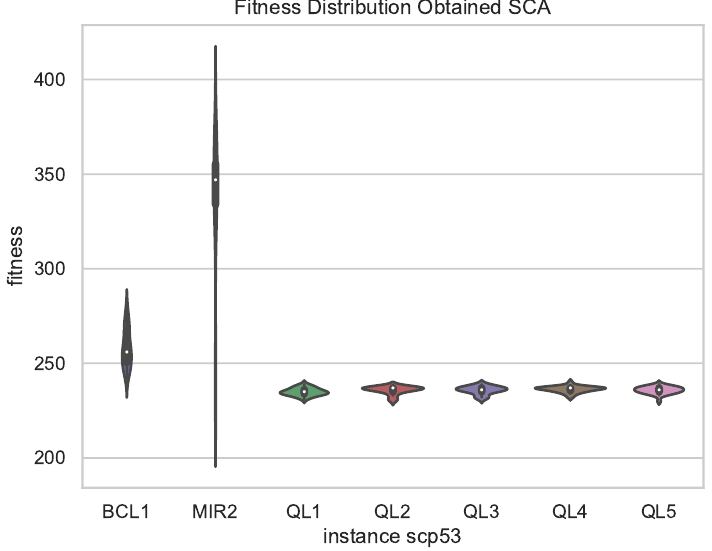
Figure 5. SCA Violin chart of instance